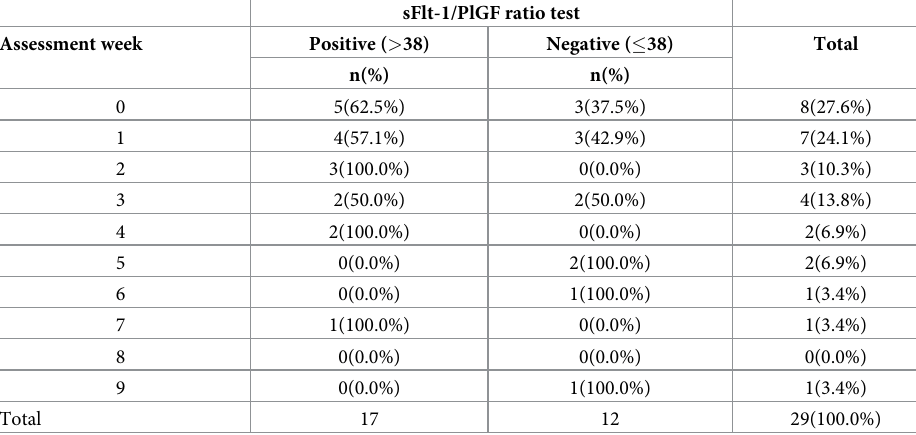
Table 1. The number of cases screened as preeclampsia by week of